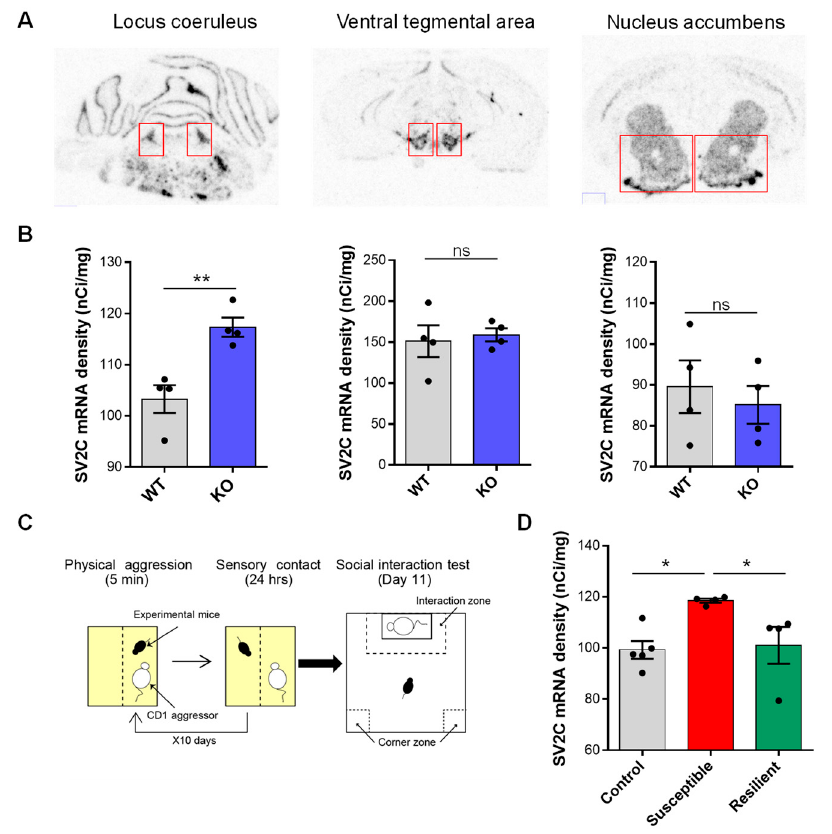
Figure 10. SV2c in situ hybridization. ( A ) Illustration of SV2c mRNA radioactive in situ labeling in the locus coeruleus (Left), ventral tegmental area (center), and nucleus accumbens (right). ( B ) Density (nCi/mg) of SV2c mRNA expression in the locus coeruleus (left), ventral tegmental area (center), and nucleus accumbens (right), measured by radioactive in situ hybridization, in WT (n = 4) and KO (n = 4) VMAT2 BDHcre mice (t 6 = − 4.25, ** p = 0.0054). ( C ) Schematic representation of the chronic social defeat stress paradigm. ( D ) Density (nCi/mg) of SV2c mRNA expression in the locus coeruleus, measured by radioactive in situ hybridization, in control (n = 5), susceptible (n = 4), and resilient (n = 4) mice to the chronic social defeat stress paradigm (F (2,10) = 5.41, p = 0.026; Post hoc test: CTL vs. SUSC: * p = 0.012, SUSC vs. RES: * p = 0.025, CTL vs. RES: p = 0.79,